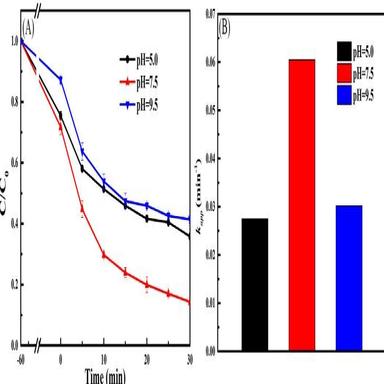
Effect of pH value on the sonocatalytic degradation of RhB (A) and the corresponding Kapp values (B).